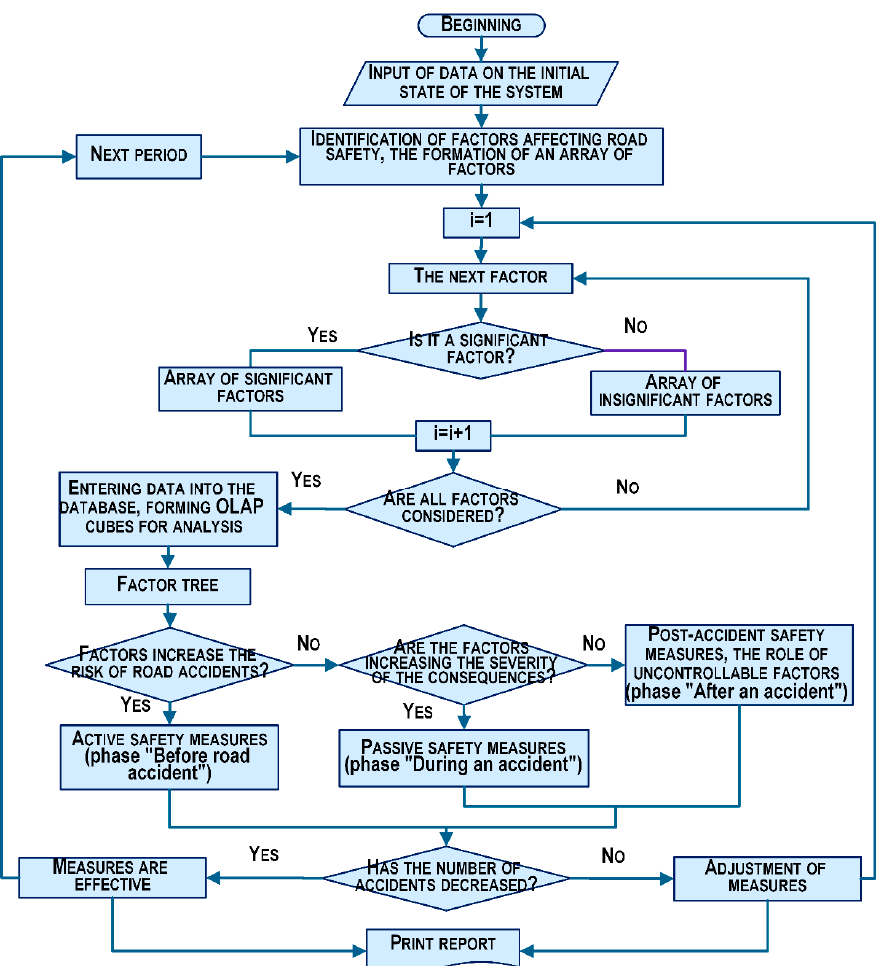
Figure 1. The algorithm to increase traffic safety.